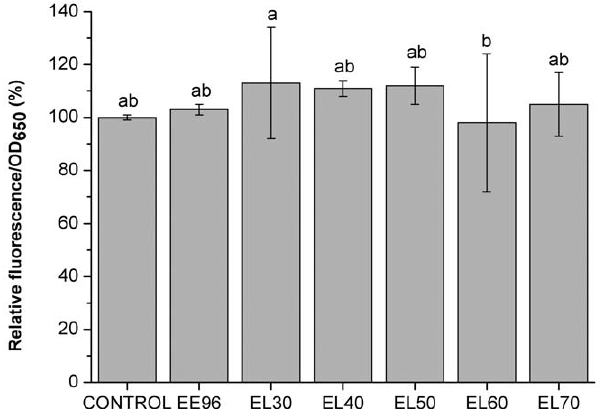
Figure 6. Cell viability of the yeast S.cerevisiae treated with EE96 and EL30 to EL70 eluates (1%). Data are means 6 S.D. (n=3), and are expressed as fluorescence normalized to OD 650 relative to control. Values followed by the same letter (a-b) are not statistically different (P , 0.05), as measured by Duncan’s test.